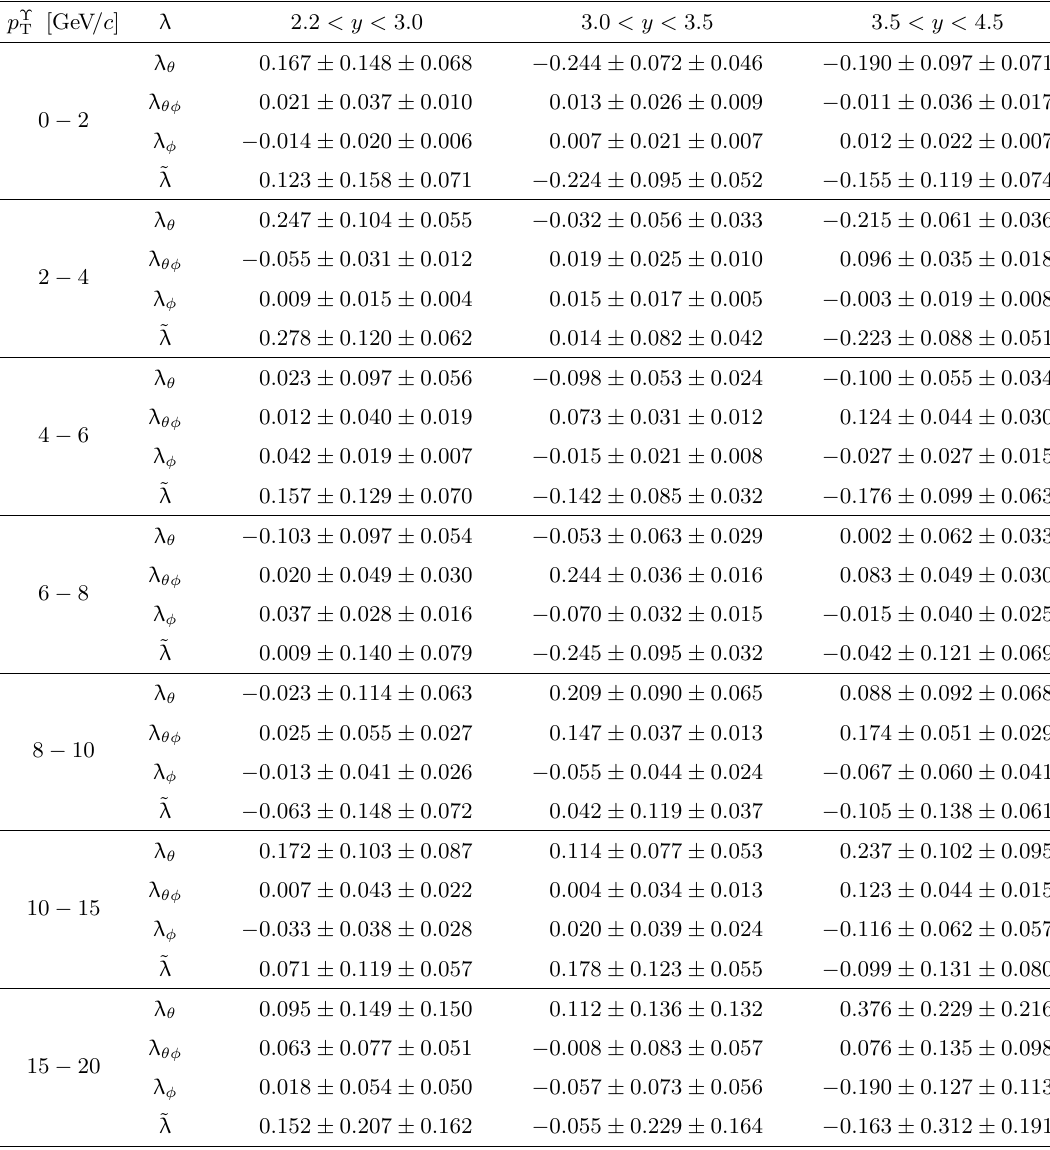
Table 11 . Values of (cid:21) (cid:18) , (cid:21) (cid:18)(cid:30) , (cid:21) (cid:30) and ~ (cid:21) measured in the HX frame for the (cid:7)(2S) produced at p s = 7 TeV. The (cid:12)rst uncertainty is statistical and the second systematic. B Polarization results for the (cid:7)(2S) state Values of the polarization parameters (cid:21)(cid:21)(cid:21) and ~ (cid:21) for the (cid:7)(2S) meson are presented in tables 11 and 12 for the HX frame, in tables 13 and 14 for the CS frame and in tables 15 and 16 p for the GJ frame for s = 7 and 8 TeV, respectively. The polarization parameters (cid:21)(cid:21)(cid:21) measured in the wide rapidity bin 2 : 2 < y (cid:7) < 4 : 5 are presented in tables 17 and 18, while the parameters ~ (cid:21) are listed in table 19.